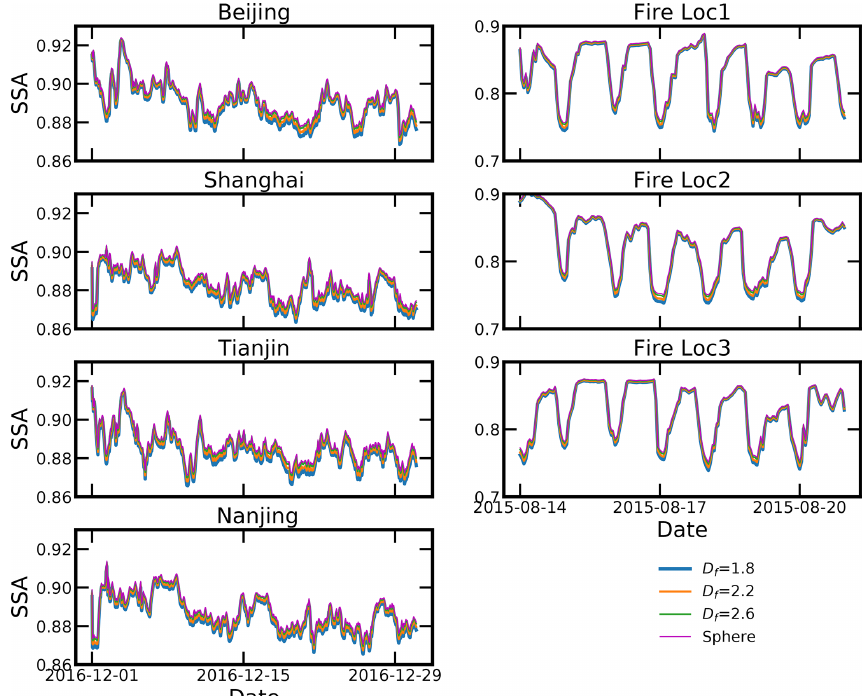
Figure 10. The comparison of SSA using different BC models, λ =